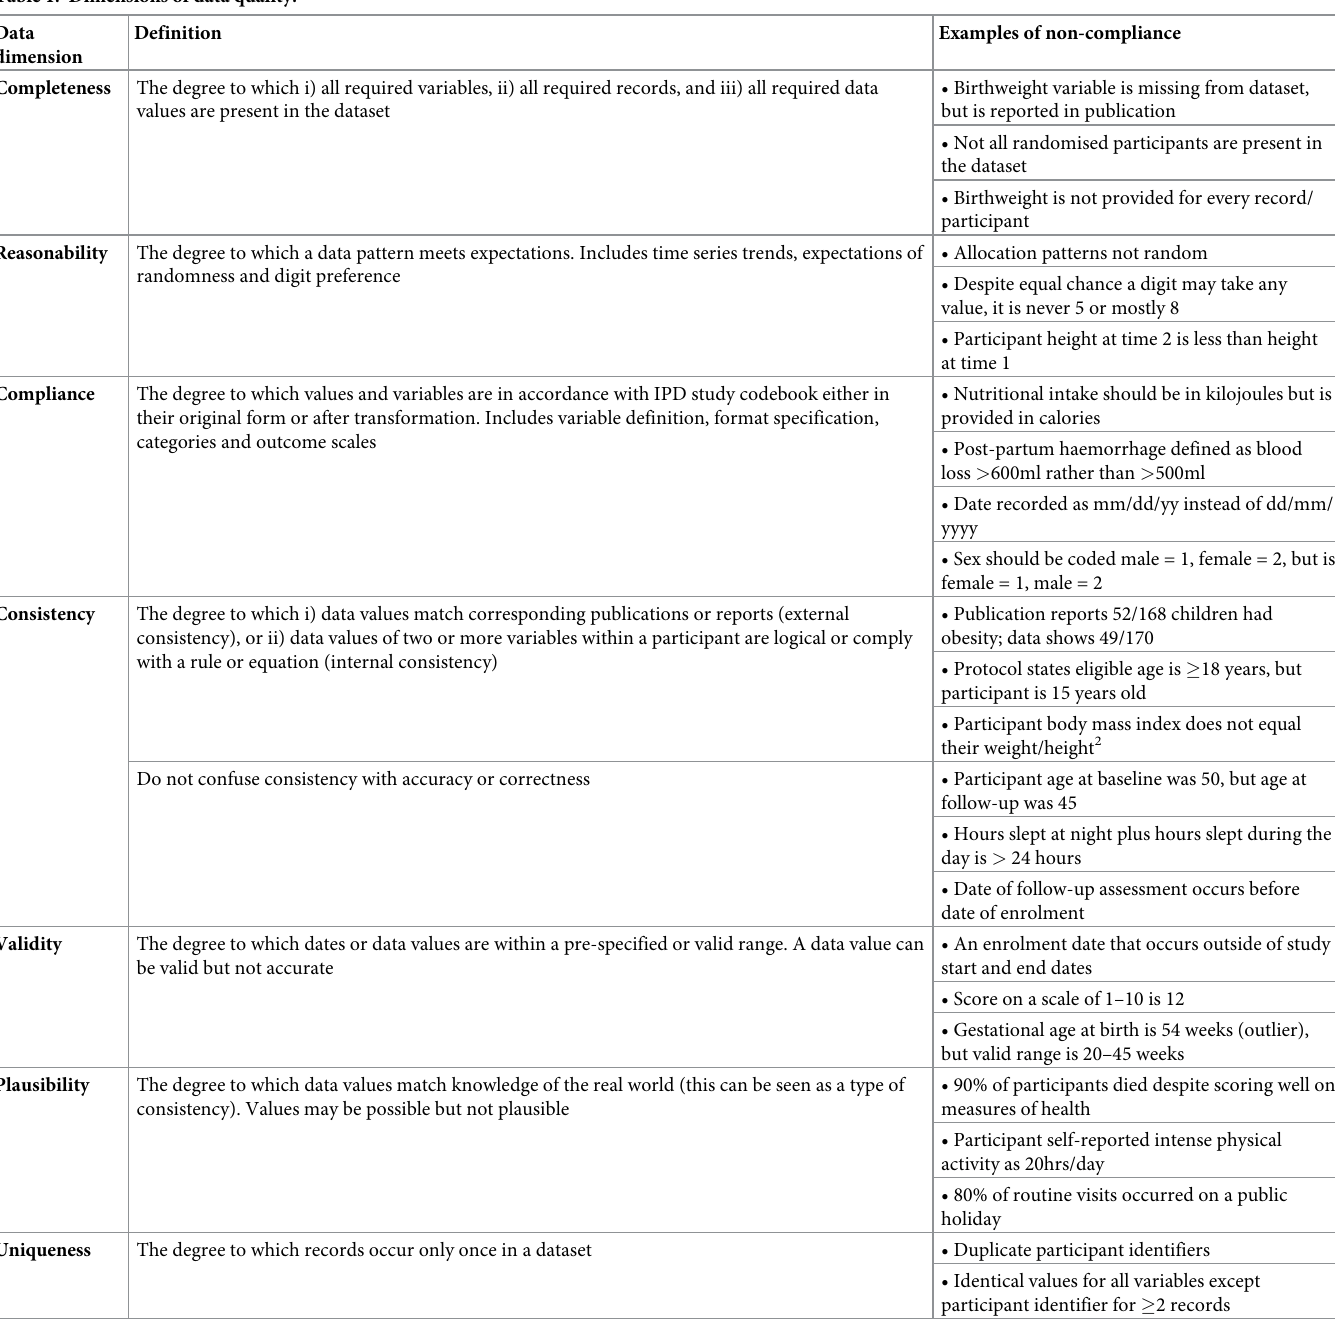
Table 1. Dimensions of data